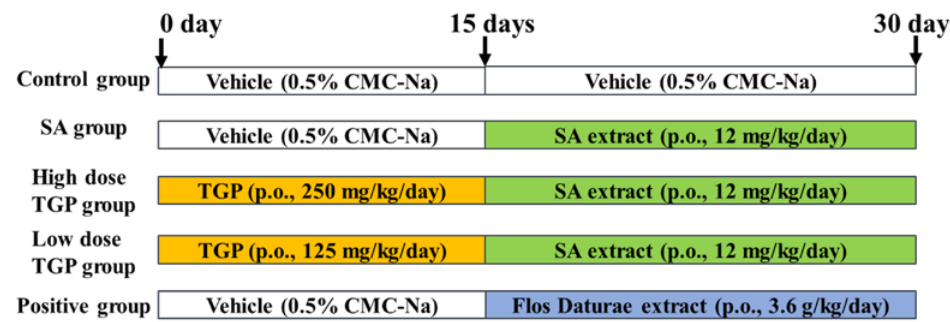
Figure 1. Schematic representation of the experimental procedure. SA, Strychnos alkaloid; TGP, total glucosides of Paeoniae Radix Alba. CMC, carboxyl methyl cellulose.